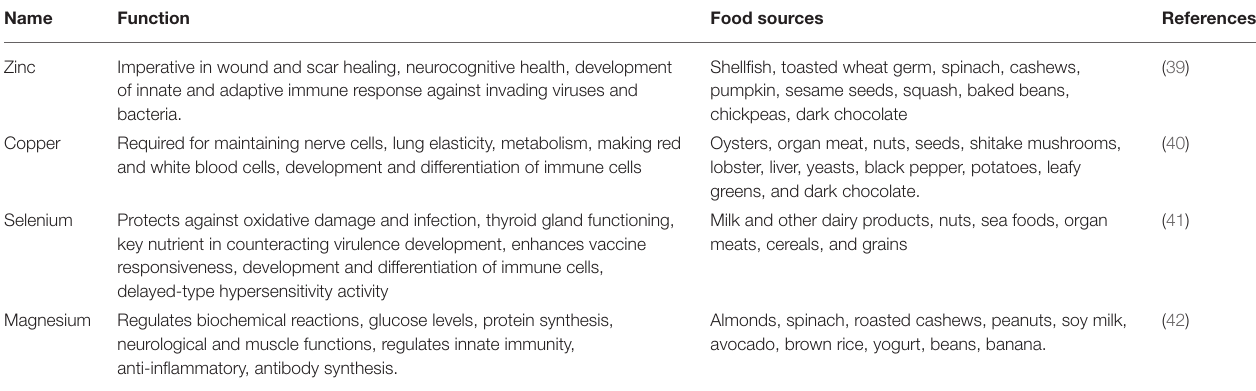
TABLE 3 | Functions of immunity building trace elements and minerals in the human body along with their food